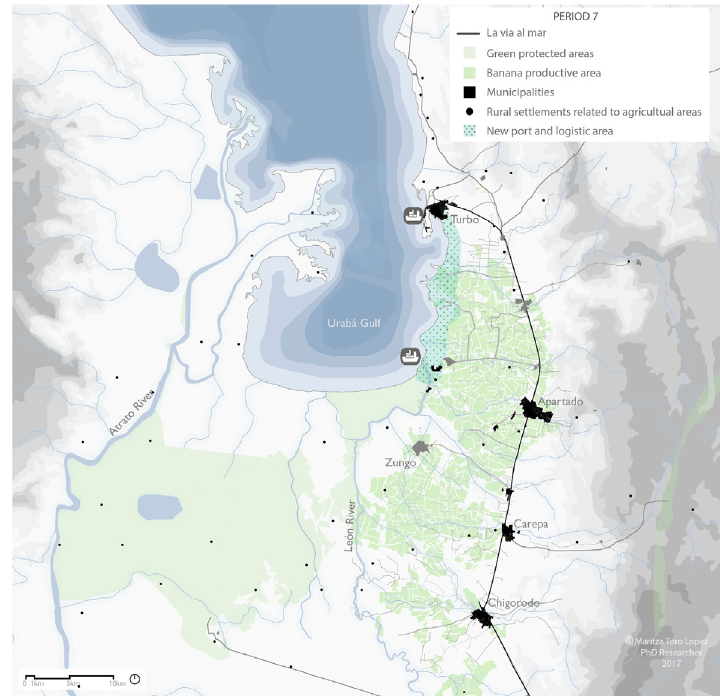
Fig. 8 . Period 7: The